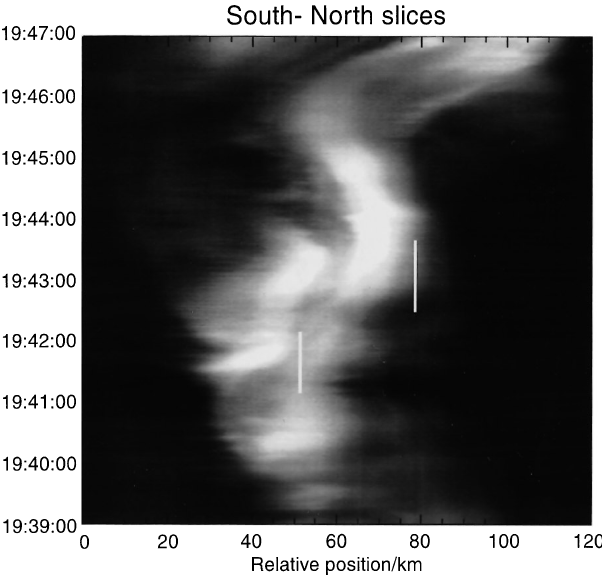
Fig. 5. Representation of brightness cuts through the auroral arc observed on 7 December 1994 along the radar scan. South is left and north is right. Cuts taken between 19:39:00 and 19:47:00 in 1-s steps are given from bottom to top . The short bars represent the radar